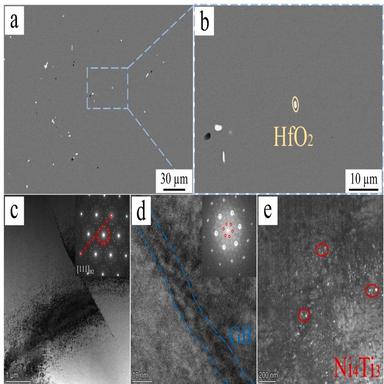
Microscopic morphology of Ni55Ti37Hf8 alloy after solution treatment, (a)-(b) SEM morphology, (c) TEM morphology, (d) High-resolution morphology, (e) Dark-field image of Ni4Ti3 phase.